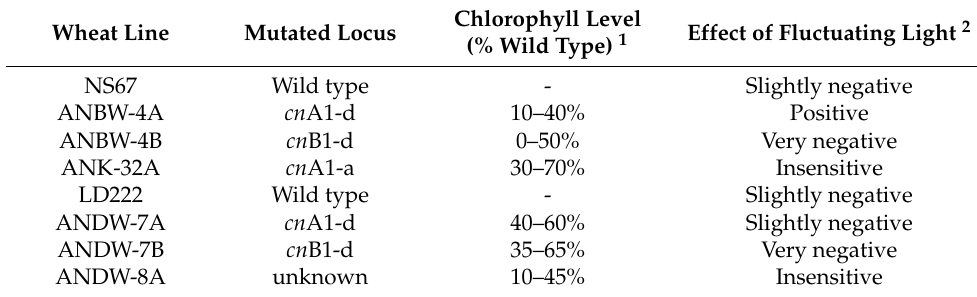
Table A1. Main characteristics of the wheat lines used in this study.